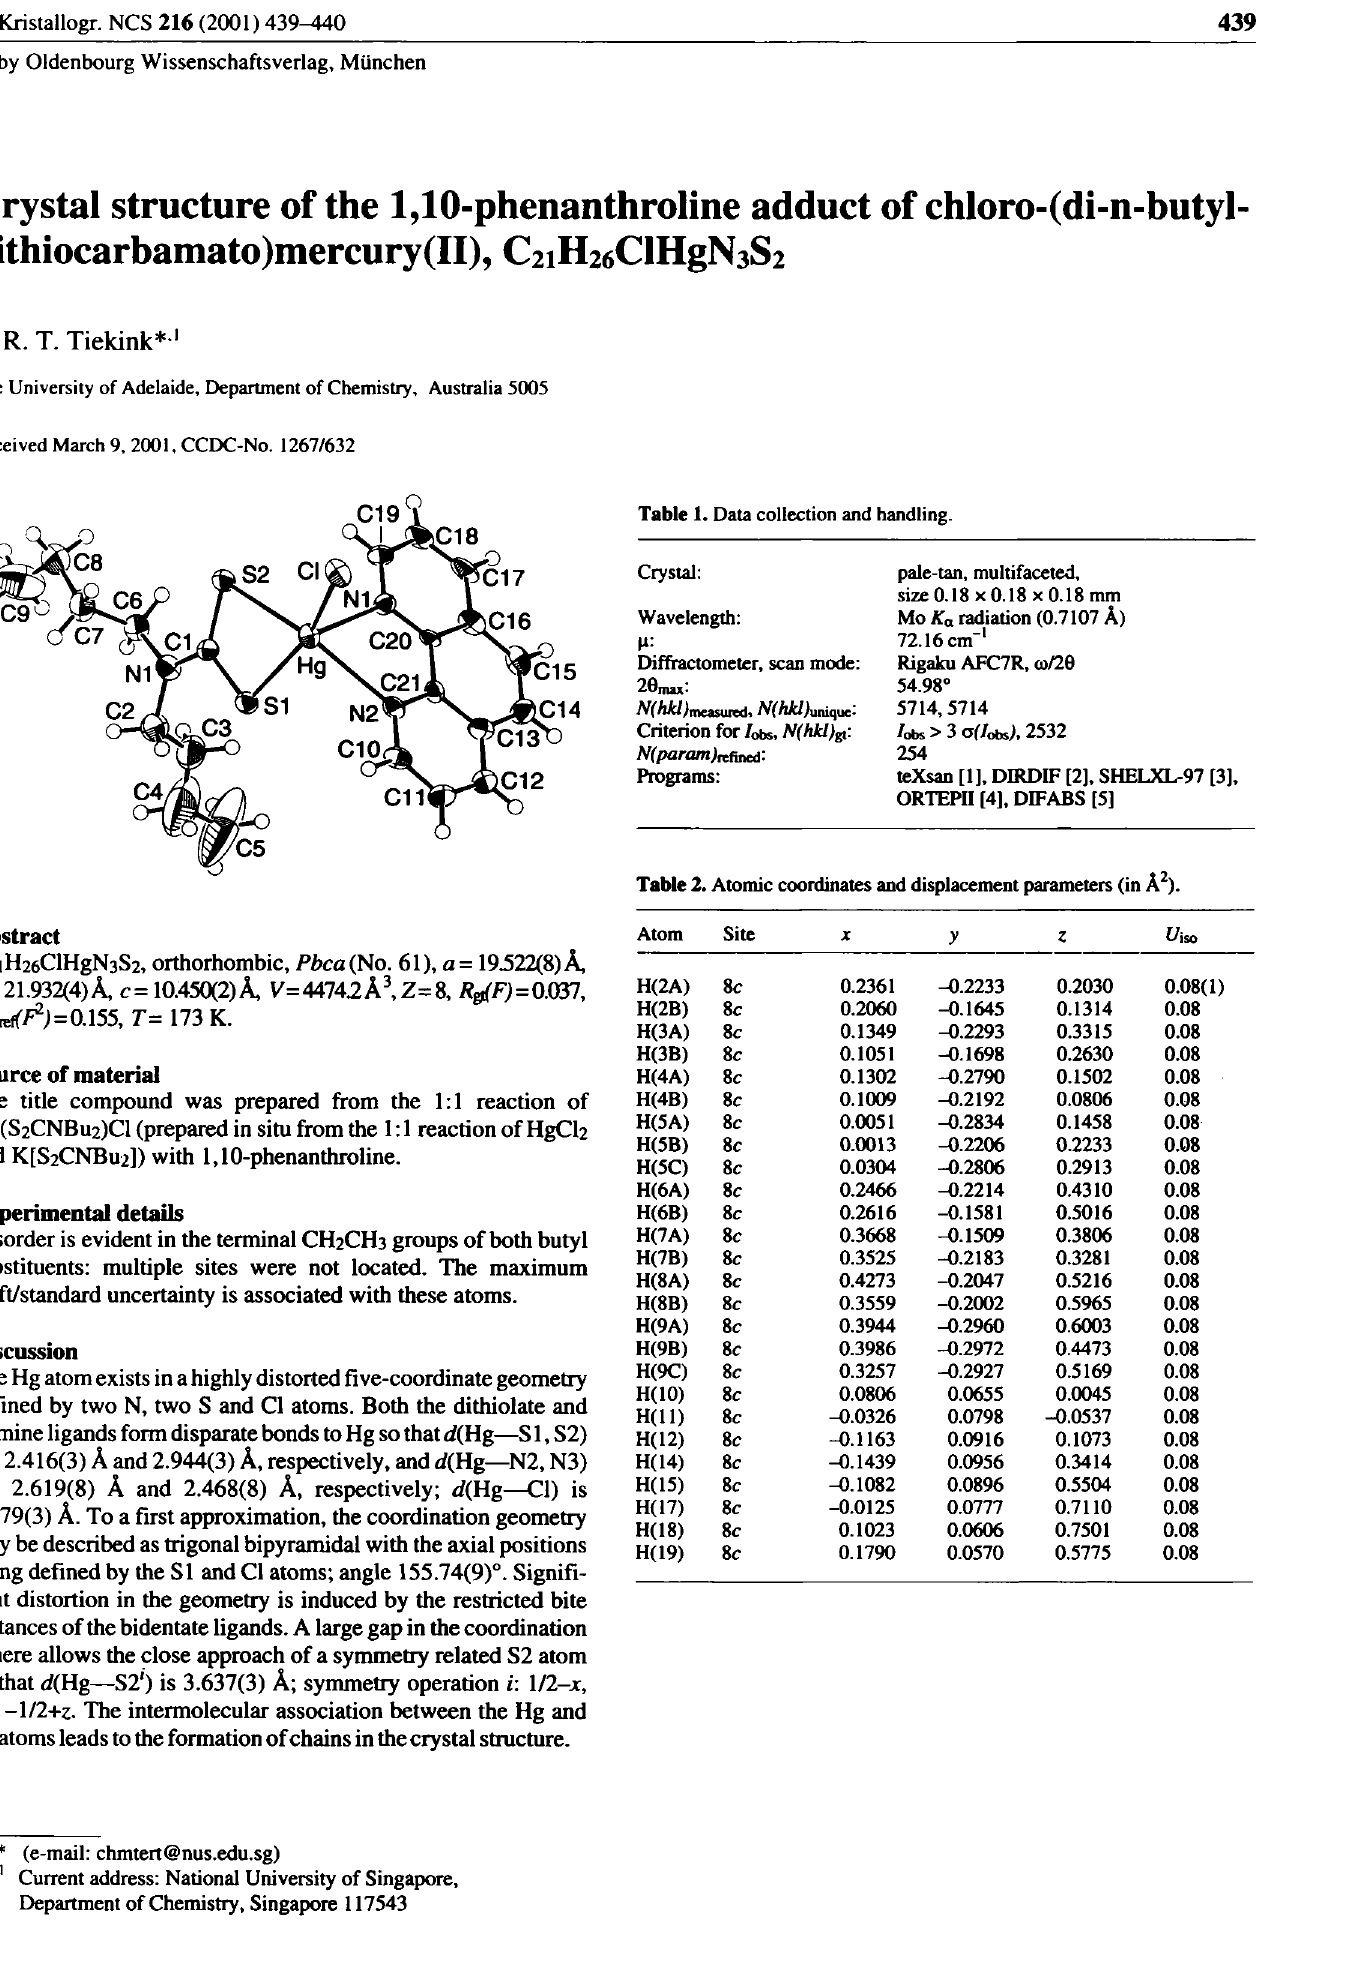
Table 2. Atomic coordinates and displacement parameters (in A 2